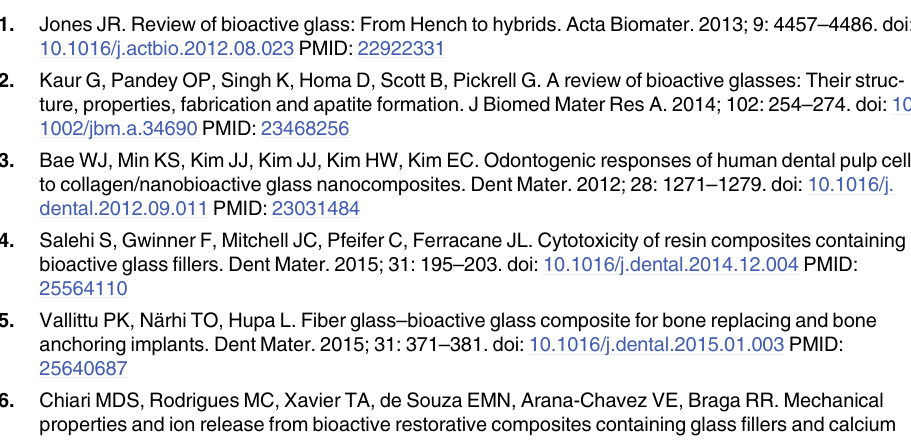
adsorp- 2 into rDPSCs within 4 hours 2